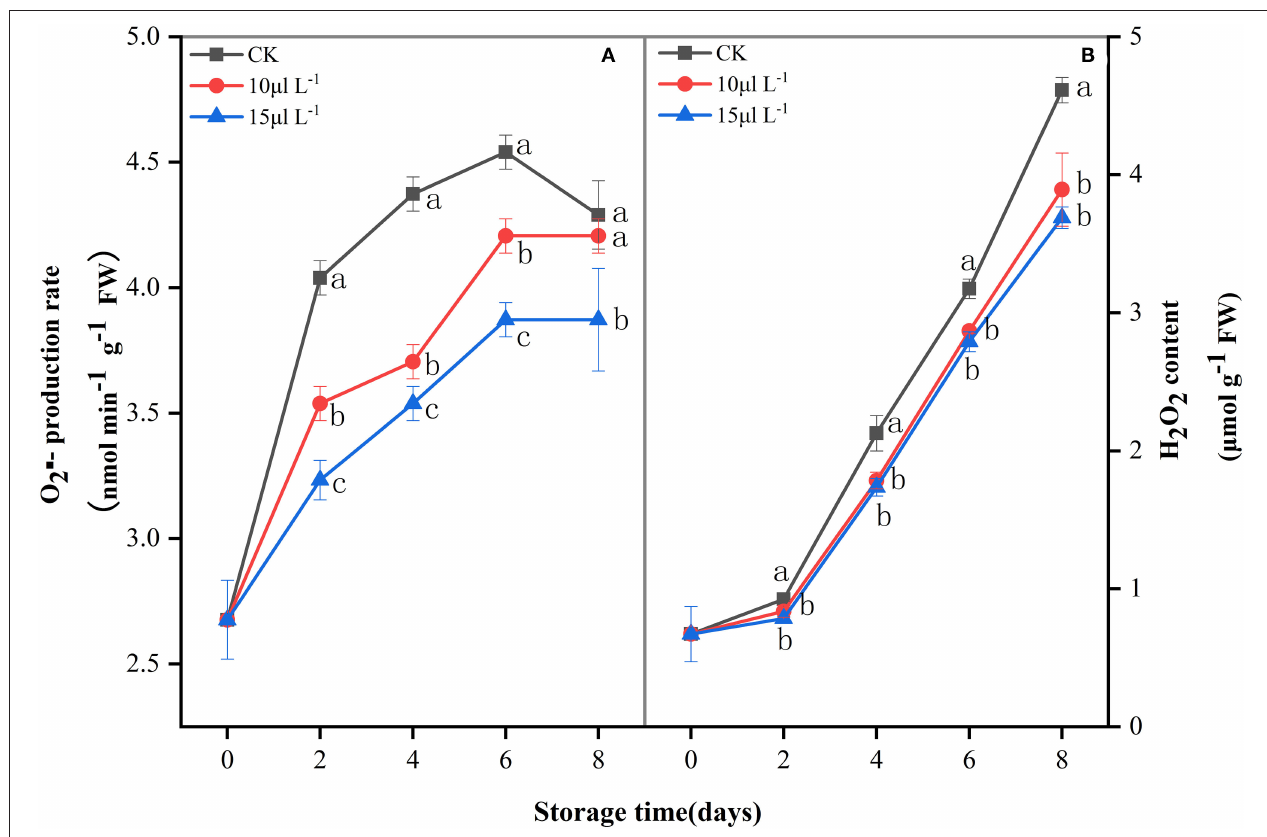
FIGURE 2 | Effects of H 2 S treatment on O ·− 2 production rate (A) and H 2 O 2 content (B) of fresh-cut Chinese water chestnuts during storage at 10 ◦ C for 8 days. Vertical bars represent the standard errors of the means. Different letters (at the same day) mean that they were significantly different (Duncan’s multiple range test, P <